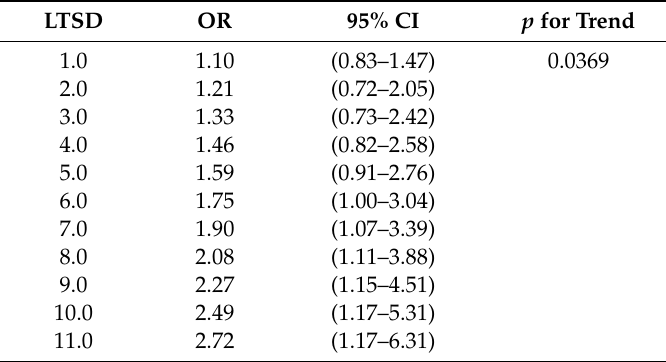
Table 4. OR and 95% CI for the restrictive cubic spline of obesity.